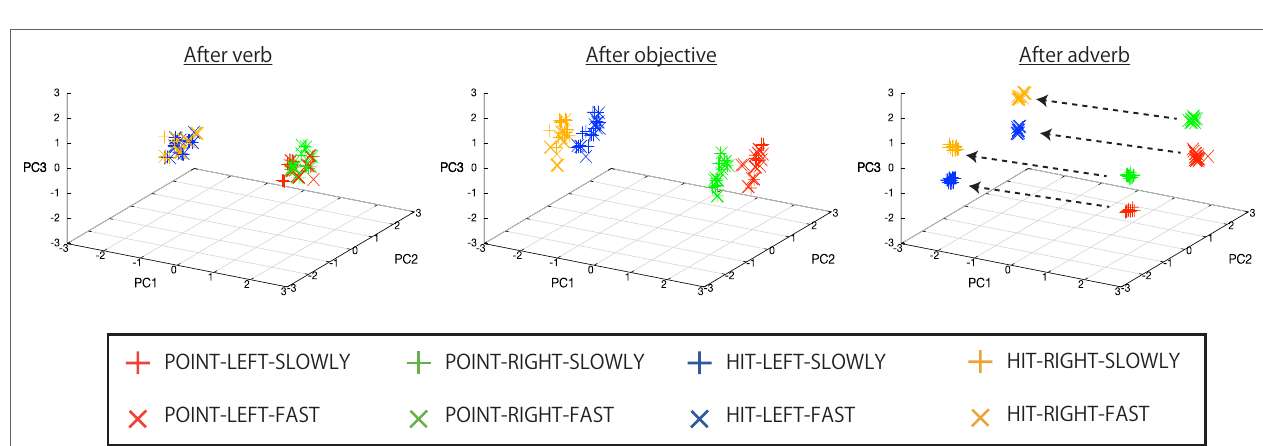
FIGURE 10 | The internal states after verb, after objective, and after adverb input, from left to right, respectively, projected onto PC1–PC3 space (CR is 52.2, 40.0, 8.5%, respectively) . The cluster structure topologically organized in accordance with the input words can be seen. The broken lines in the right graph roughly indicate the vectors that connect average linking points of two behaviors differing in only the verb element (e.g., HIT-LEFT-SLOWLY and POINT-LEFT-SLOWLY), that is, the POINT-HIT axis. The minimum cosine between two of the four vectors calculated in the original 30-dimensional space was 0.972, indicating that they are almost parallel to each other. In the cases of the LEFT-RIGHT axis and the SLOWLY-FAST axis, the minimum cosines are 0.938 and 0.977, respectively. In contrast, the cosines (1) between the POINT-HIT axis and the LEFT-RIGHT axis, (2) between the POINT-HIT axis and the SLOWLY-FAST axis, and (3) between the LEFT-RIGHT axis and the SLOWLY-FAST axis were 0.079, 0.075, and 0.035, respectively, indicating that these axes are close to orthogonal.